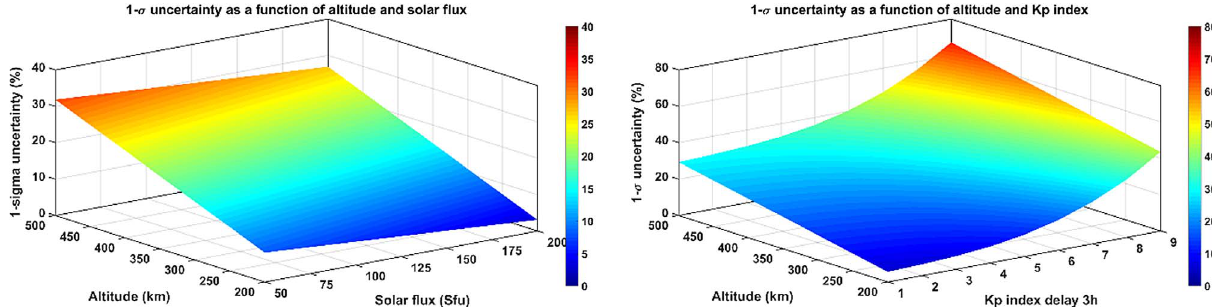
Fig. 9. 3D plot of the 1- r uncertainty (in percent) as a function of altitude and drivers : (left) solar fl ux, (right)